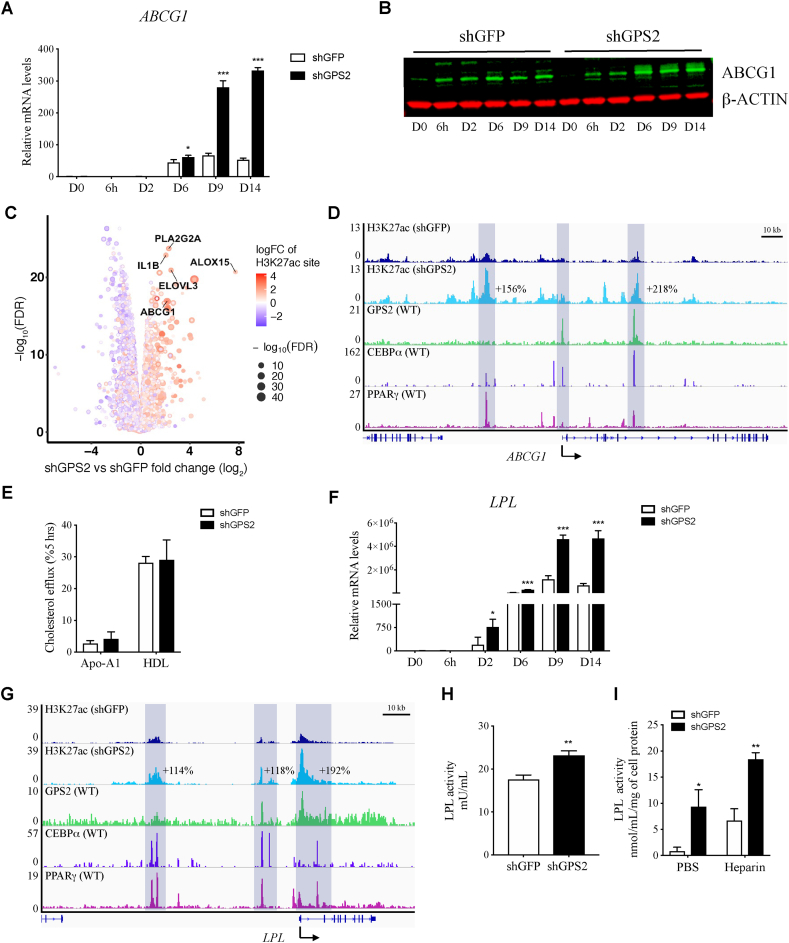
GPS2 depletion increases the expression of ABCG1 and expression and activity of LPL. (A) mRNA and (B) protein levels of ABCG1 during adipocyte differentiation in shGFP and shGPS2 hMADS cells (n = 3). (C) Volcano plot of global gene expression along with logFC of H3K27ac sites (color from blue to red) and -log (FDR) (dot size) in shGPS2 vs shGFP adipocytes at day 14. (D) ChIP-seq tracks of H3K27ac, GPS2, C/EBPα (GSE24326), and PPARγ (P5_adipocytes GSE115421) at the ABCG1 locus in human adipocytes. (E) Cholesterol efflux to apoA-1 or HDL determined in shGFP and shGPS2 adipocytes, day 14 (n = 5). (F) LPL mRNA levels in shGFP vs shGPS2 adipocytes, day 14 (n = 3). (G) ChIP-seq tracks of H3K27ac, GPS2, C/EBPα (GSE24326), and PPARγ (P5_adipocytes GSE115421) at the LPL locus in human adipocytes. (H) Intracellular and (I) secreted LPL activity in shGFP vs shGPS2 adipocytes, day 14 (n = 3). All of the data are represented as mean ± standard deviation (SD). ∗p < 0.05, ∗∗p < 0.01, ∗∗∗p < 0.001, and Student's t-test.